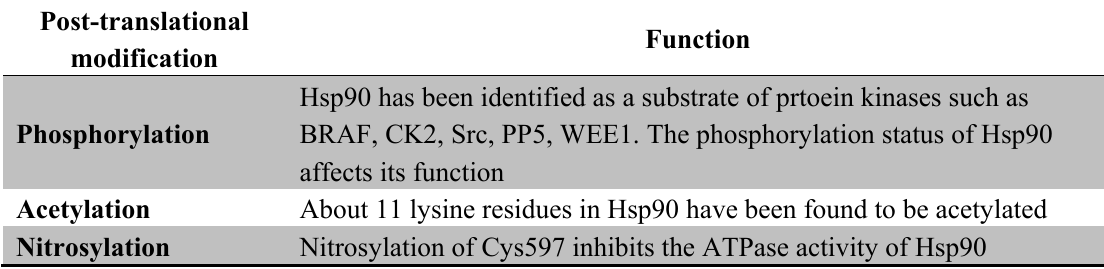
Table 2. Post-translational modification of HSP90.